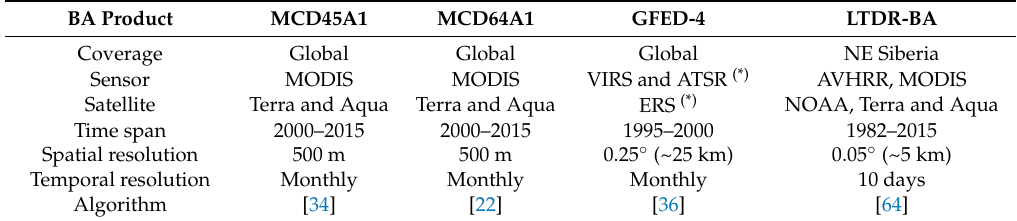
Table 2. Comparison between MCD45A1, MCD64A1, GFED-4, and LTDR Burned Area (BA) products for this study.